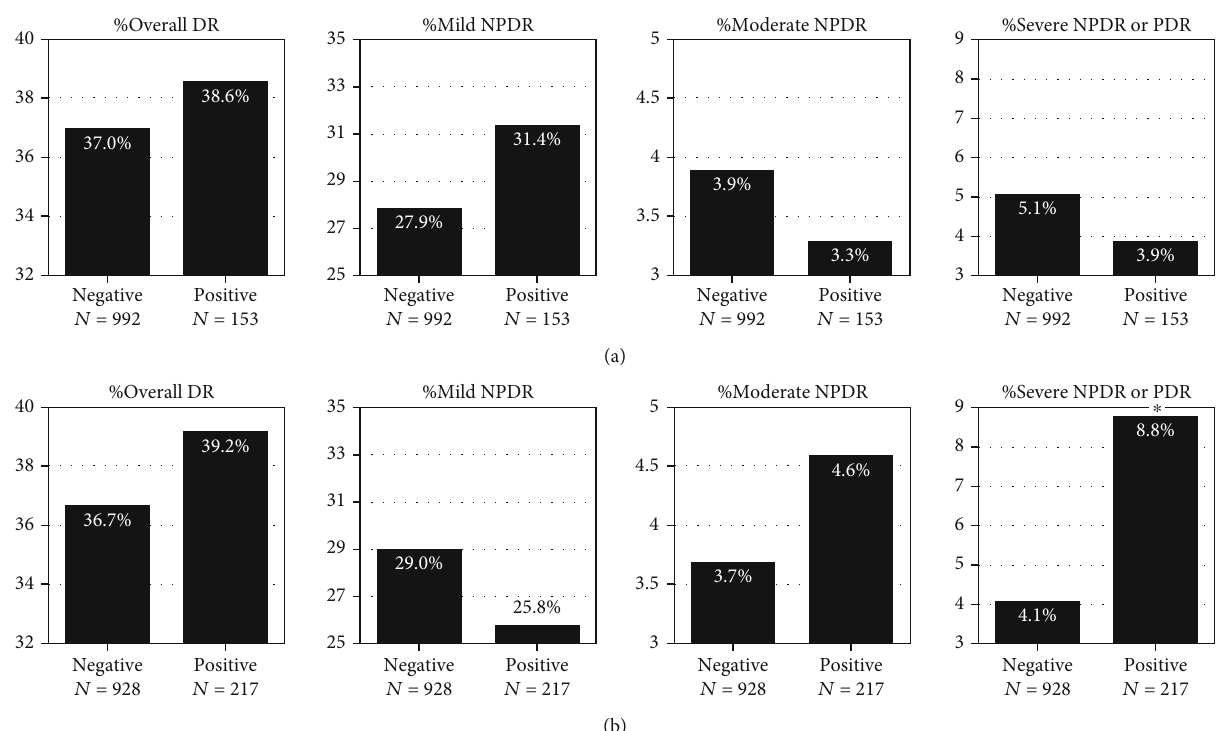
Figure 3: The variation of di ff erent stages of DR prevalence with serum TPOAb (a) and TgAb (b). DR: diabetic retinopathy; NPDR: nonproliferative diabetic retinopathy; PDR: proliferative diabetic retinopathy; TPOAb: thyroid peroxidase antibody; TgAb: thyroglobulin antibody. The ∗ indicates that the corresponding prevalence in the positive group was signi fi cantly higher than the negative group ( p < 0 : 05